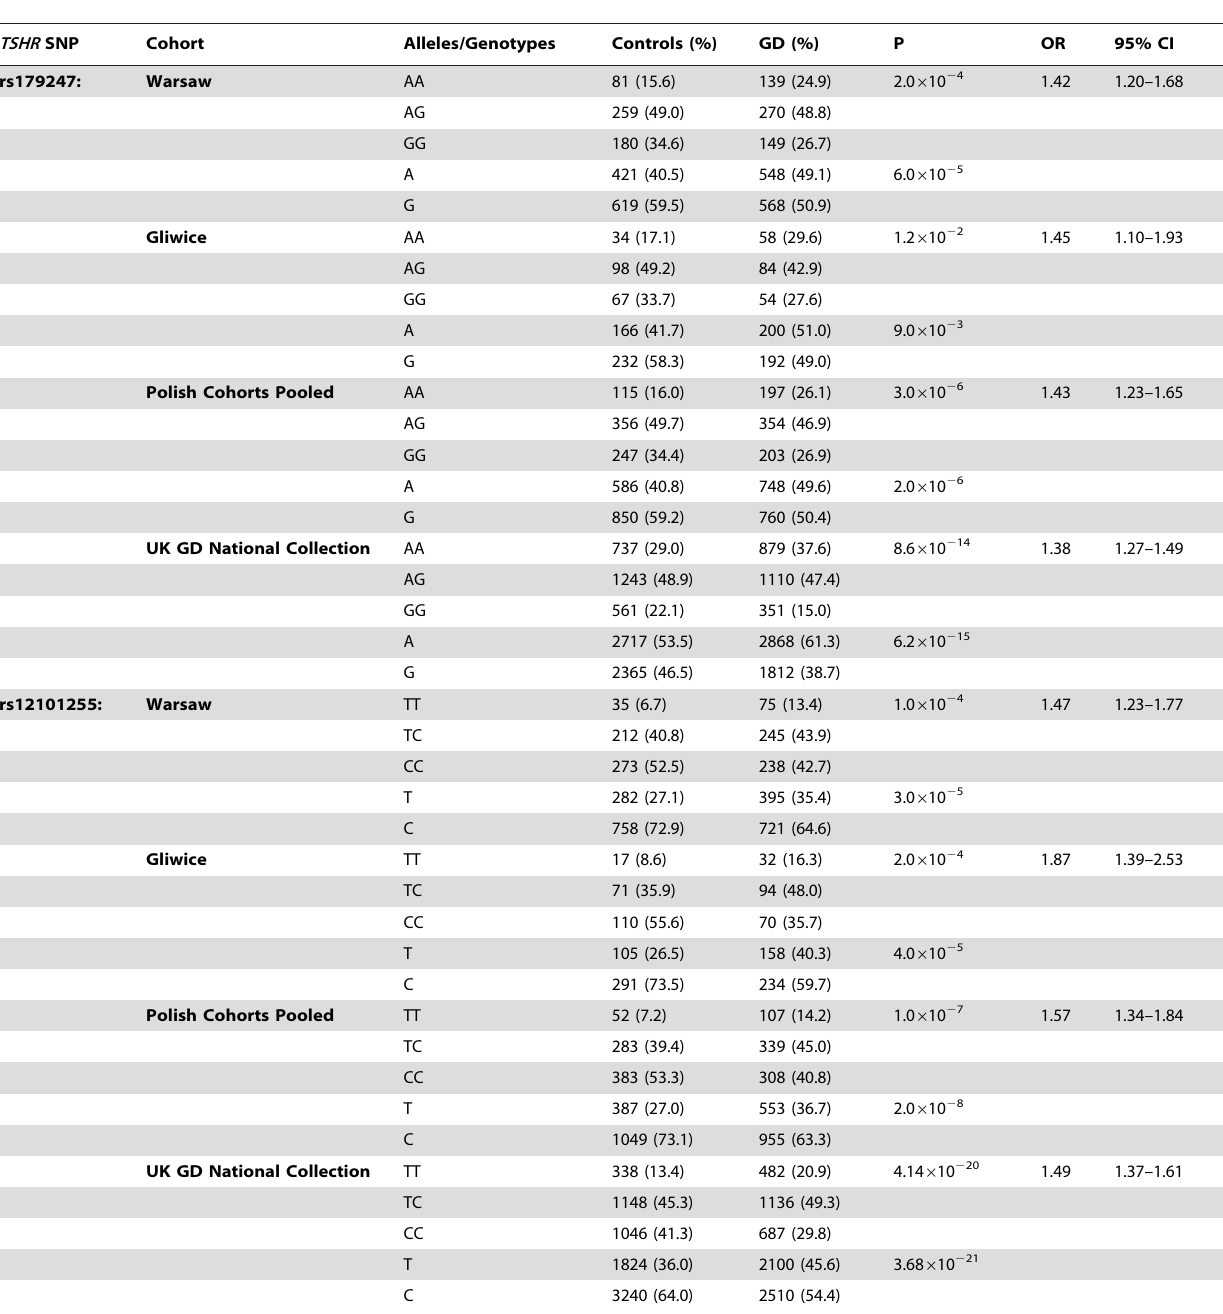
Table 1. TSHR genotype and allele frequencies in Warsaw, Gliwice, combined Polish cohorts and UK case-control cohorts.